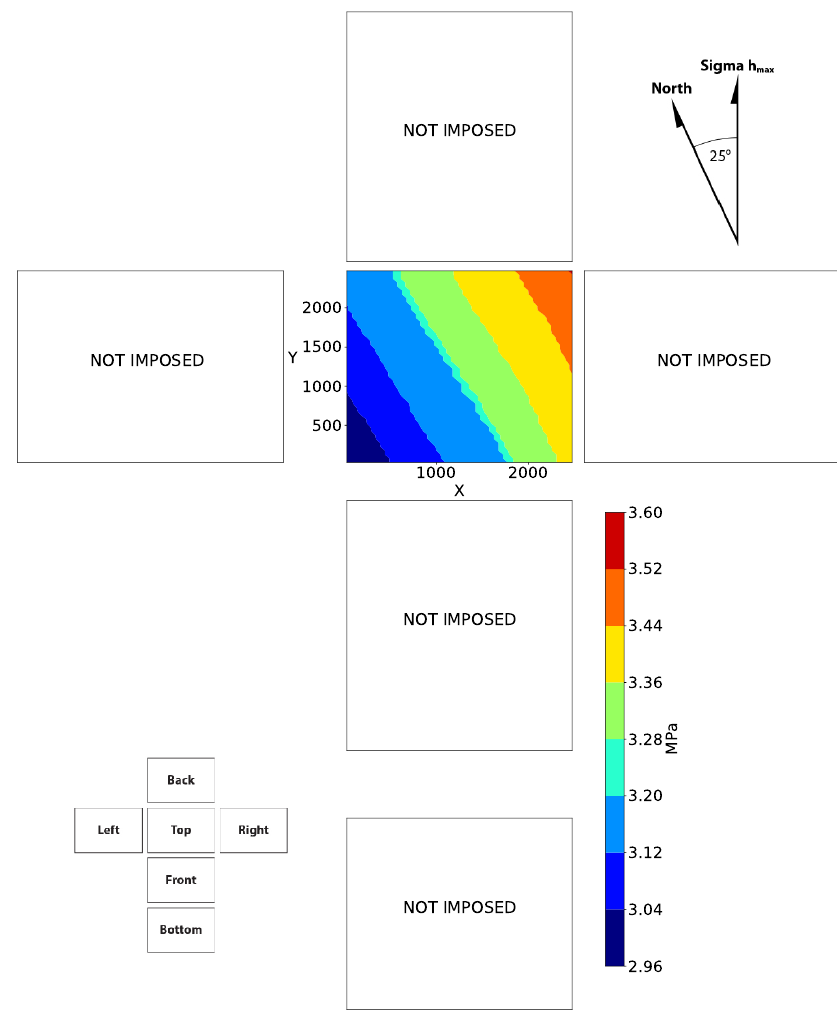
Figure 10. Pressure boundary